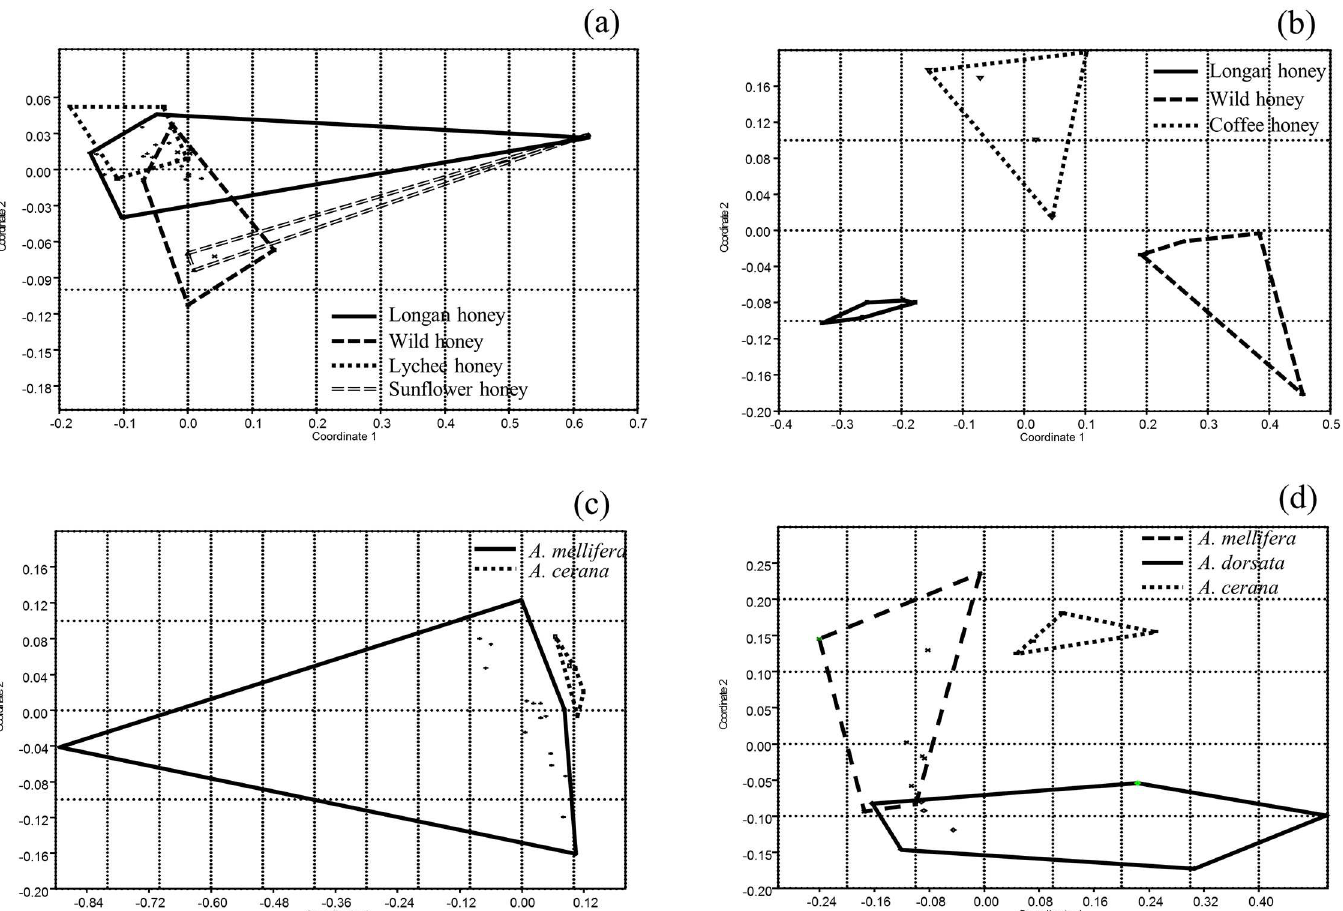
Fig 2. Groupings among volatile organic compounds of (a) longan honey, wild honey, lychee honey and sunflower honey from A . mellifera (b) longan honey, wild honey, coffee honey from A . cerana showing how VOCs from same honeybee species are clustered or separated from VOCs from different floral sources; (c) longan honey from A . mellifera and A . cerana (d) wild honey from A . mellifera , A . dorsata and A . cerana showing how VOCs from samefloral sources are clustered or separated from VOCs from different honeybee